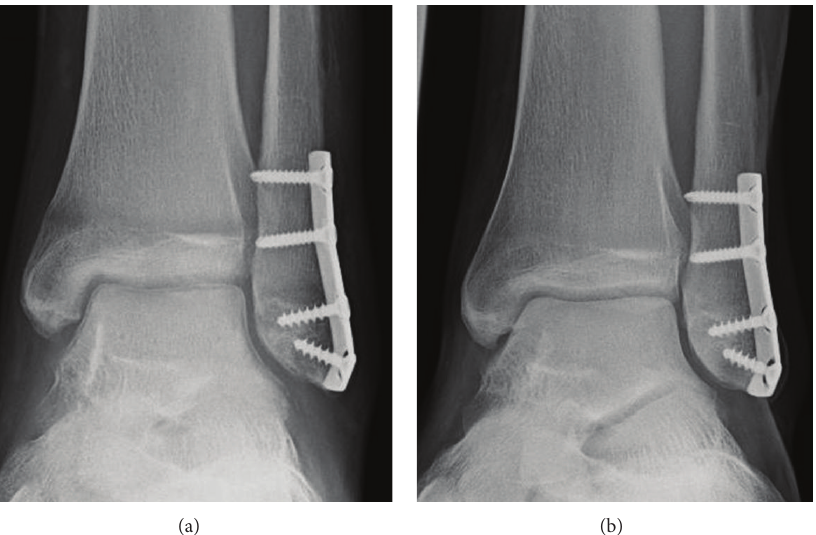
Figure 5: Serial radiographs of the left ankle after osteosynthesis of a distal fibula fracture. With immobility subchondral osteopenia of the talus as well as the distal tibial, epiphysis could be found (a) which disappeared after the resumption of normal activity